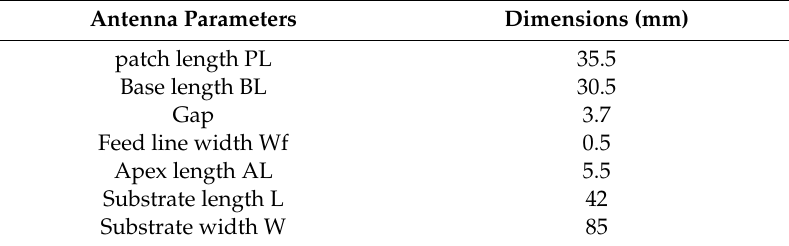
Table 2. Antenna B Parameters.